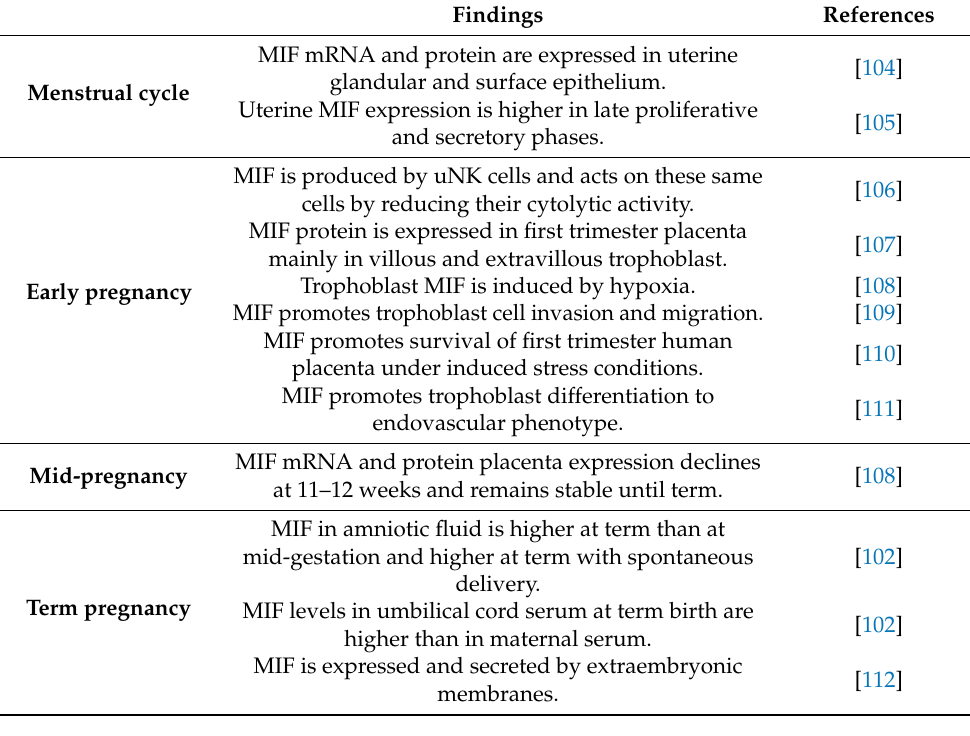
Table 1. MIF in human reproduction.